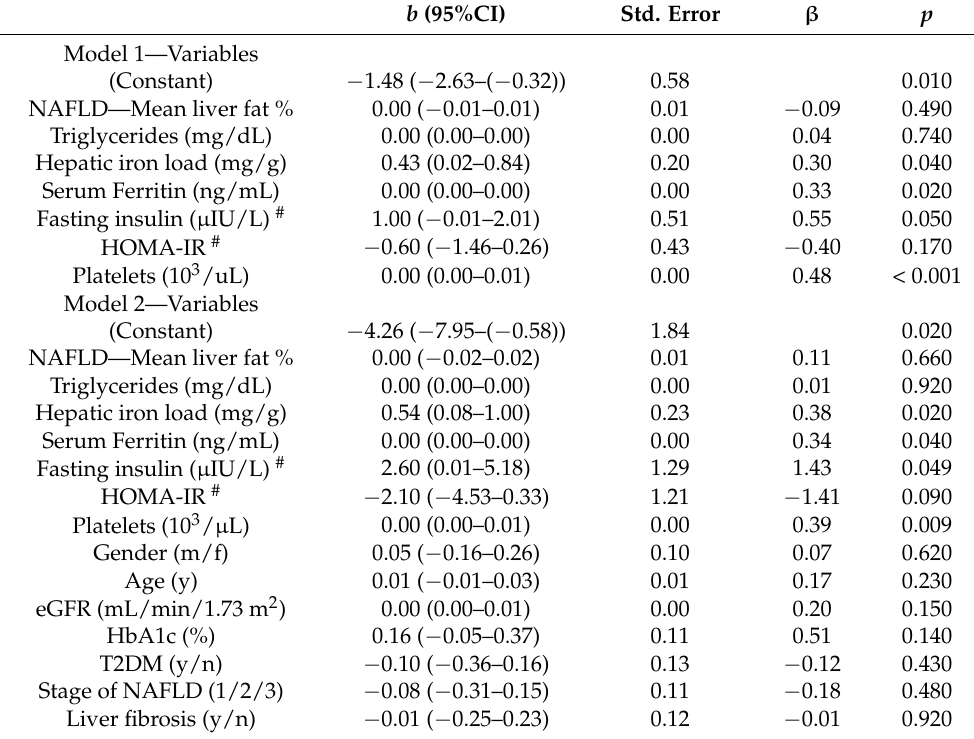
Table 4. Predictors of UACR at multivariate analysis after controlling for confounding variables in patients with non-alcoholic fatty liver disease and metabolic